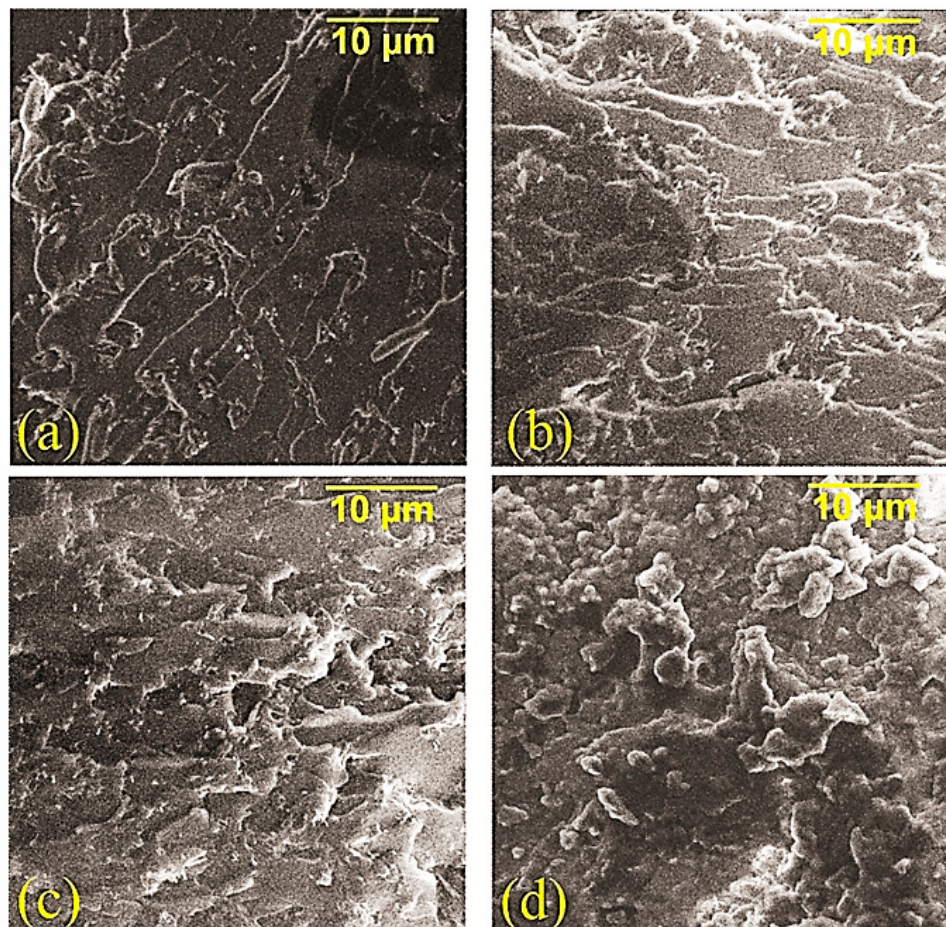
Figure 4. SEM data of composites: ( a ) PC; ( b ) PC + MWCNT; ( c ) PC + MWCNT + microwave (oligomer); ( d ) PC + MWCNT + microwave (composite).